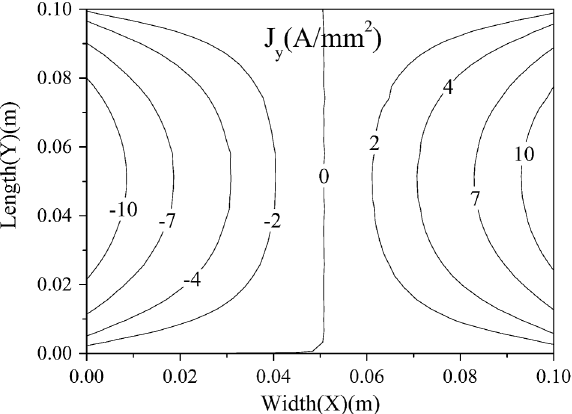
FIG. 4. Contour plot of Y component of the eddy current in the SS plate of dimension ð 0 : 1 ; 0 : 1 ; 0 : 002 Þ m 3 for density, j y 50 Hz frequency and 0.923 21 T peak field.